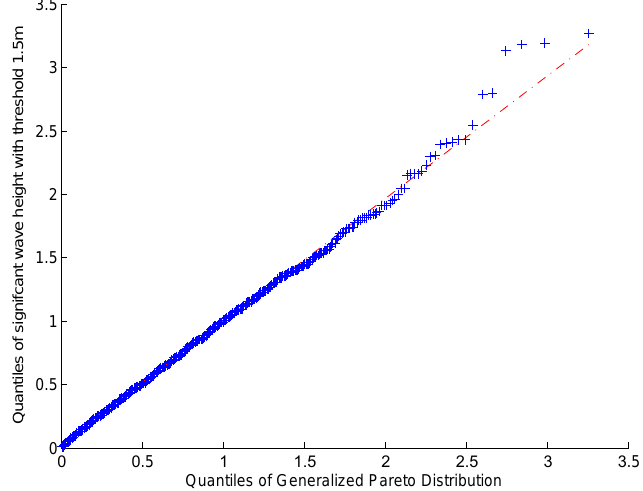
Figure 5. Quantile-Quantile (Q-Q) plot of the fitted Generalized Pareto distribution to the significant wave height over 1.5 m